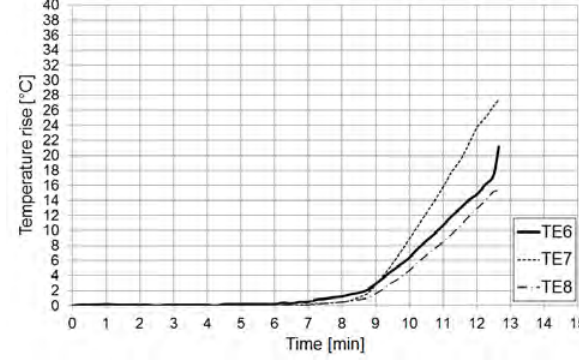
Figure 7: Temperature/time graph of furnace heating conditions (solid line – standard temperature-time curve, dashed line – aver- age temperature inside the furnace).